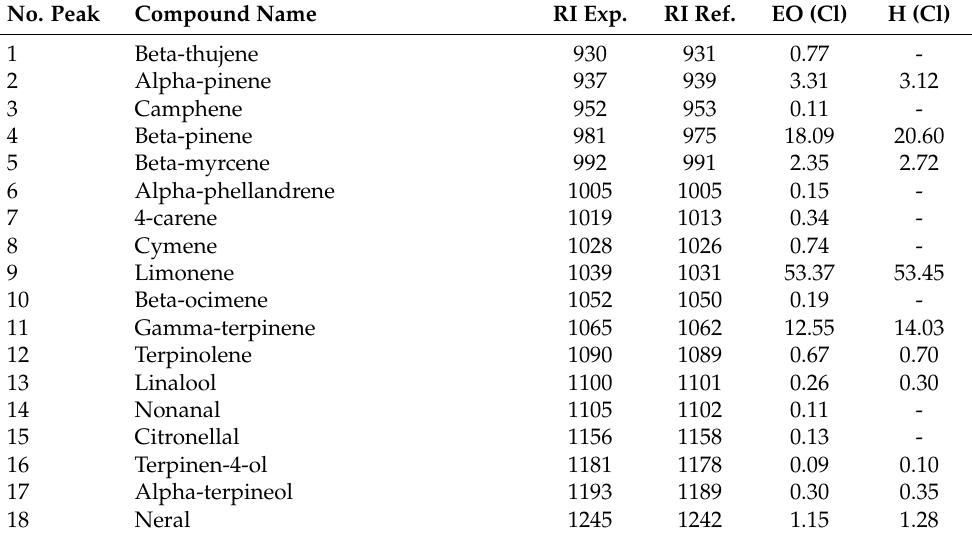
Table 3. Phytochemical composition (%) of essential oil (EO) and hydrolate (H) of Citrus limon (Cl) used in this study, via GC-MS. RI exp: retention index calculated with our experimental results; RI ref: Retention index found in the literature for the same compound (source: